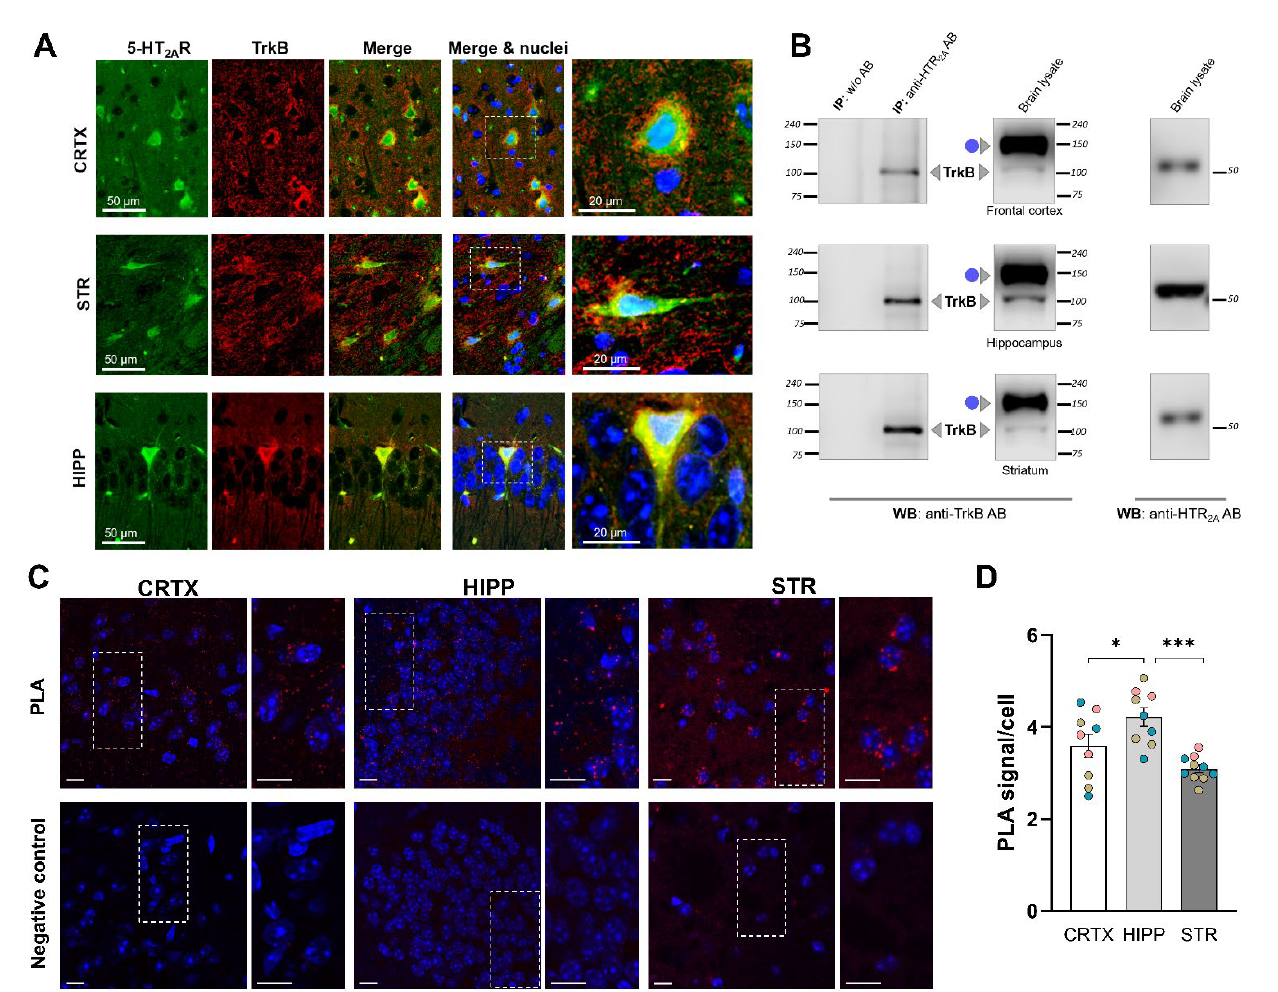
Figure 2. Interaction between receptors 5-HT 2A and TrkB in the mouse brain. ( A ) Co-localization of 5-HT 2A and TrkB in the mouse brain. Brain slices from cortex (CRTX), striatum (STR), and hippocampus (HIPP) were subjected to immunohistochemistry for the detection of 5-HT 2A (green) and TrkB (red), followed by confocal microscopy. Nuclei are shown in blue. Right: Merged images and a magnified view of representative neurons. ( B ) Co-immunoprecipitation between 5-HT 2A and TrkB in brain lysates. Whole-brain homogenates were prepared from different brain areas and subjected to IP with an anti-5-HT 2A receptor antibody, followed by WB analysis with anti-TrkB and anti-5- HT 2A antibodies. AB: antibody; IP, immunoprecipitation; WB, Western blot; ● glycosylated TrkB. Results are representative of at least three independent experiments. ( C ) Detection of 5-HT 2A –TrkB heteroreceptor complexes in mouse brain slices using proximity ligation assay (PLA). Representative images of PLA staining in cortex (CRTX), hippocampus (HIPP), and striatum (STR) are shown as a single Z-stack. Nuclei are shown in blue, and PLA blobs are shown in red. Negative control was performed omitting primary antibodies. Scale bar, 20 μm. ( D ) Quantification of the 5-HT 2A -TrkB heterodimer density. Data are presented as means ± SEM ( n = 6 mice). Each colored dot represents data obtained for one mouse. * p < 0.05, *** p < 0.001 (one-way ANOVA).